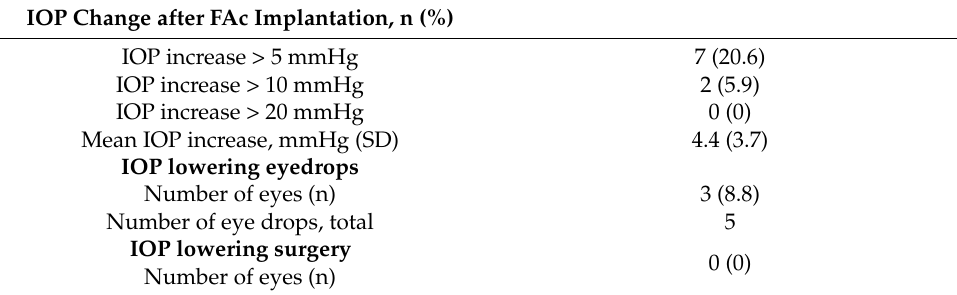
Table 4. IOP change following FAc implantation.